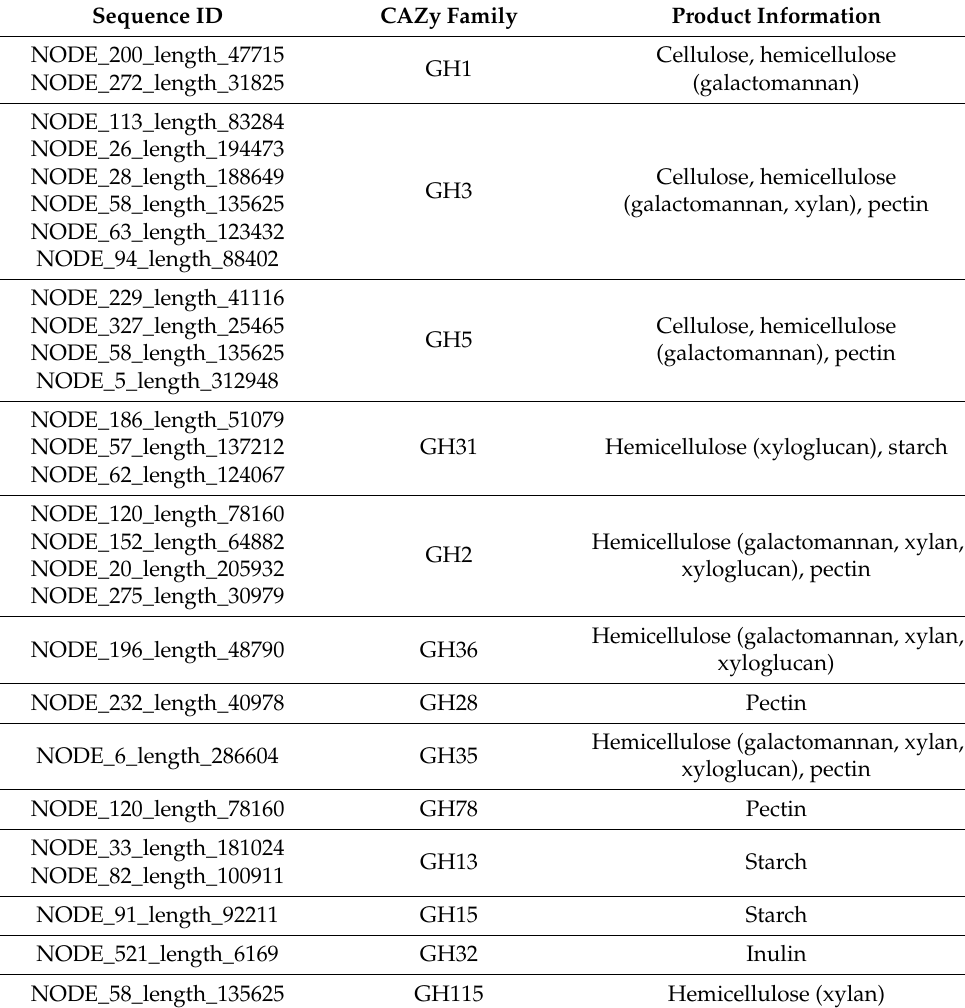
Table 2. Prediction of Ophiocordyceps australis CCMB661 genes involved in plant biomass degradation (from CAZy family) and their respective product